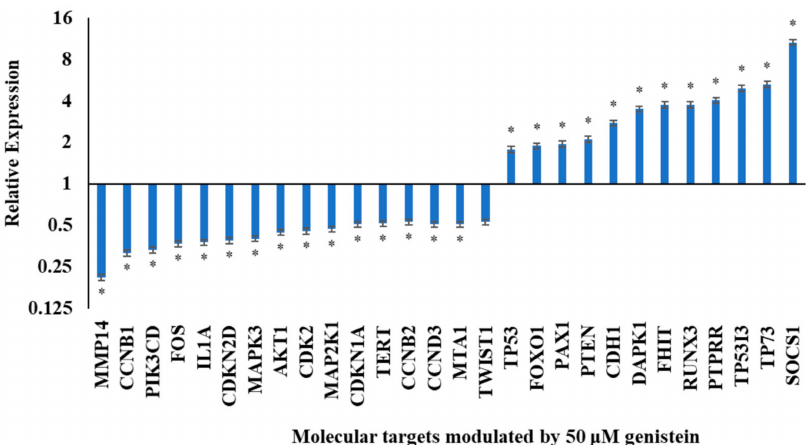
Figure 1. Expression analysis of molecular targets including cell cycle regulators, tumour suppressors and genes involved in phosphatidylinositol 3-kinase (PI3K) and mitogen activated kinase-like protein (MAPK) signaling (* p ≤ 0.05) after 48 h treatment with 50 µ M genistein. Table 1. Genes modulated in HeLa cells treated by 50 µ M